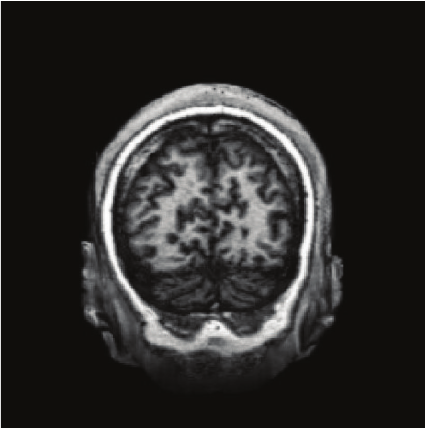
Figure 1: An example of MR image: 3D view from behind with part of hindbrain